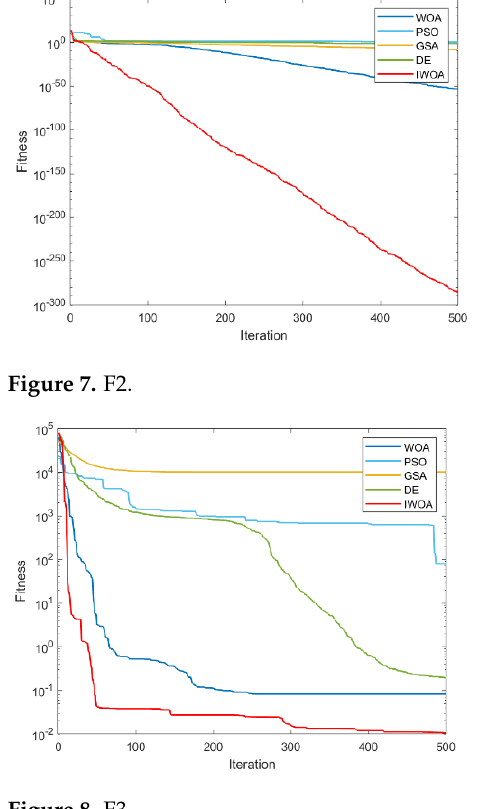
Figure 8. F3. Figure 8. F3.